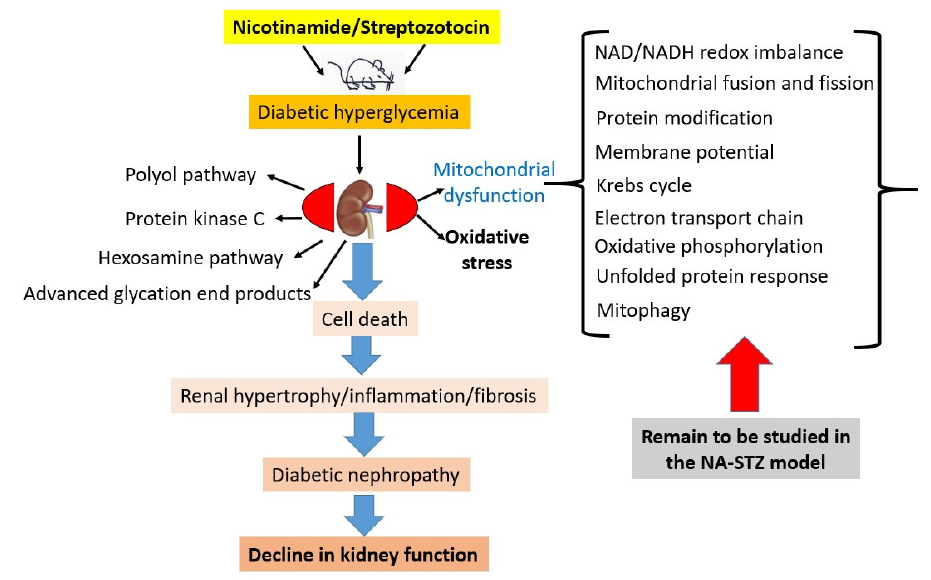
Figure 6. Potential mechanisms underlying diabetic nephropathy in the NA-STZ animal model. While common deleterious mechanisms operate in the kidney upon hyperglycemic challenge, those potential mitochondrial mechanisms underlying kidney injury remain to be elucidated (right side of the figure). These deleterious mechanisms would eventually converge on renal hypertrophy and renal fibrosis, leading to phenotype of diabetic nephropathy and kidney functional decline. Finally, this NA-STZ diabetes animal model may also be used to evaluate any poten- tial renoprotective effects of caloric restriction [142–144], intermittent caloric restriction